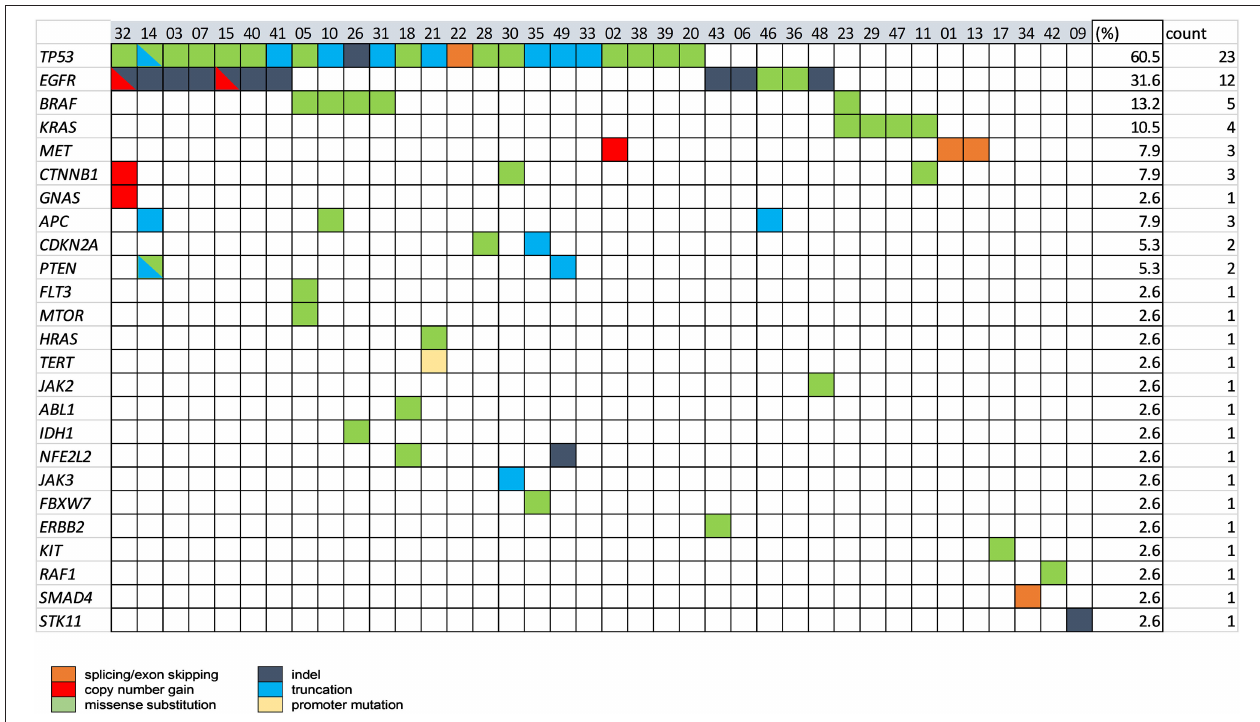
FIGURE 3 | The spectrum of genomic alterations in NSCLC was detected by plasma NGS testing. Baseline plasma samples for 53 NSCLC cases were tested with the 49-gene panel LiquidHALLMARK® assay. Cases with ≥ 1 alteration are presented ( n = 38), 15 cases with no alteration detected were excluded from the presentation. Genes with no alteration detected among all cases were also excluded from the presentation. Percentage (%) and number of cases carrying a mutation in each gene are shown in the right-most